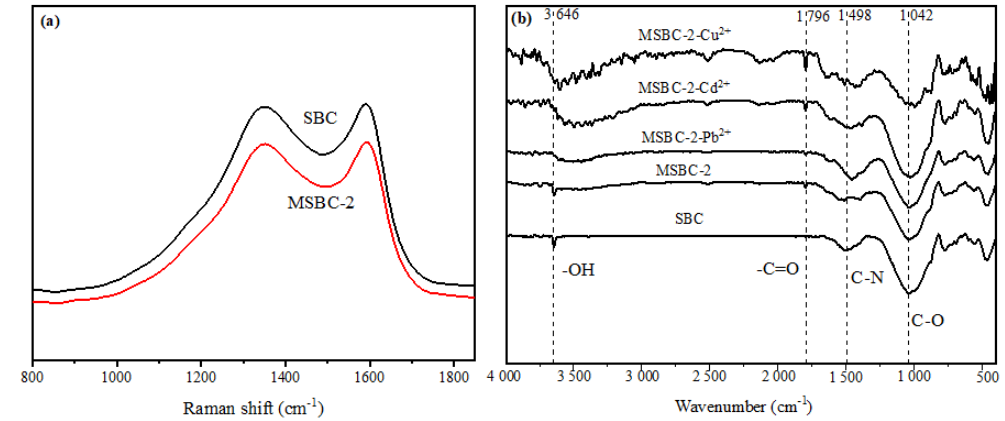
Figure 2. Raman spectrum ( a ) and FTIR spectrum ( b ) of SBC and MSBC-2.